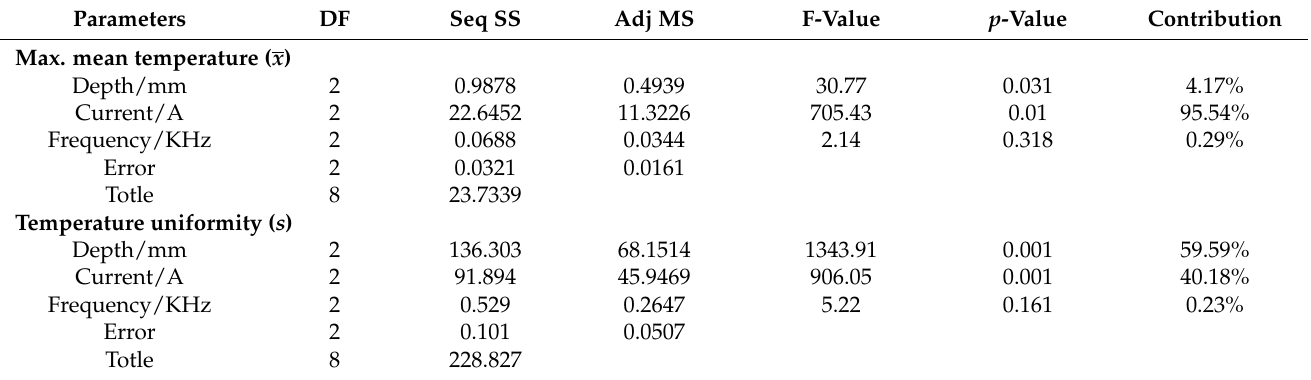
Table 6. ANOVA for max. mean temperature and temperature